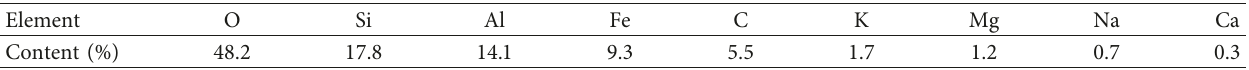
Table 1: Element composition.